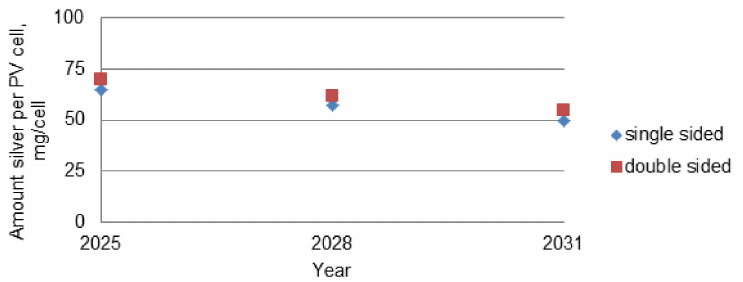
Figure 2. The trend for remaining silver per PV cell for chosen concept p-type (front and rear side of PV cell, where value for cell size are 166 and 166 mm 2 )